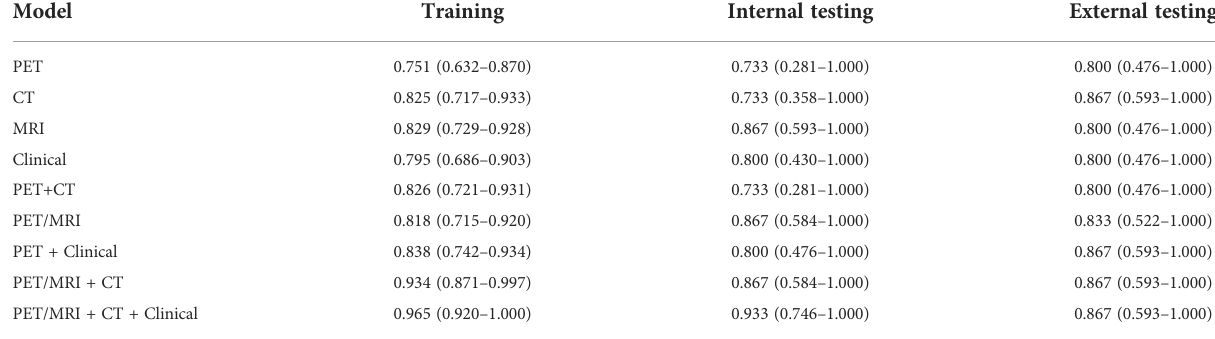
TABLE 2 AUC values of different prediction models in the training set, internal testing set and external testing